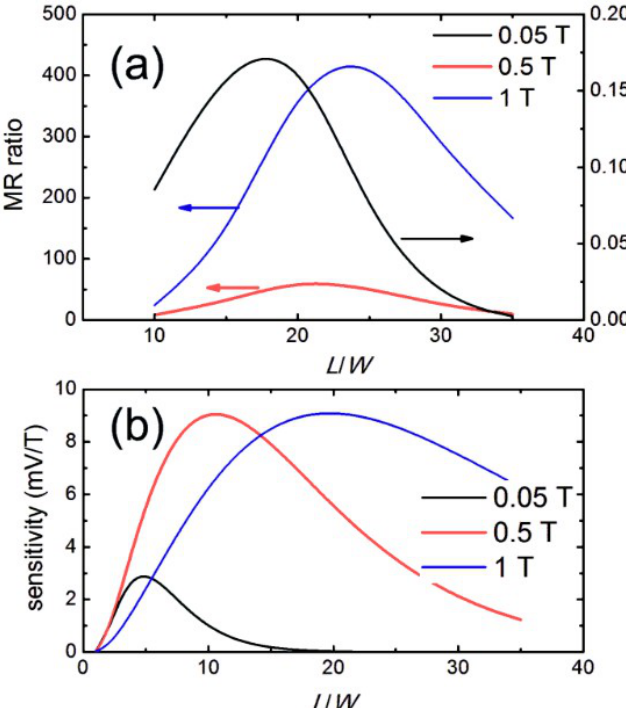
Figure 5. ( a ) MR ratio and ( b ) sensitivity as a function of length/width L / W at various magnetic